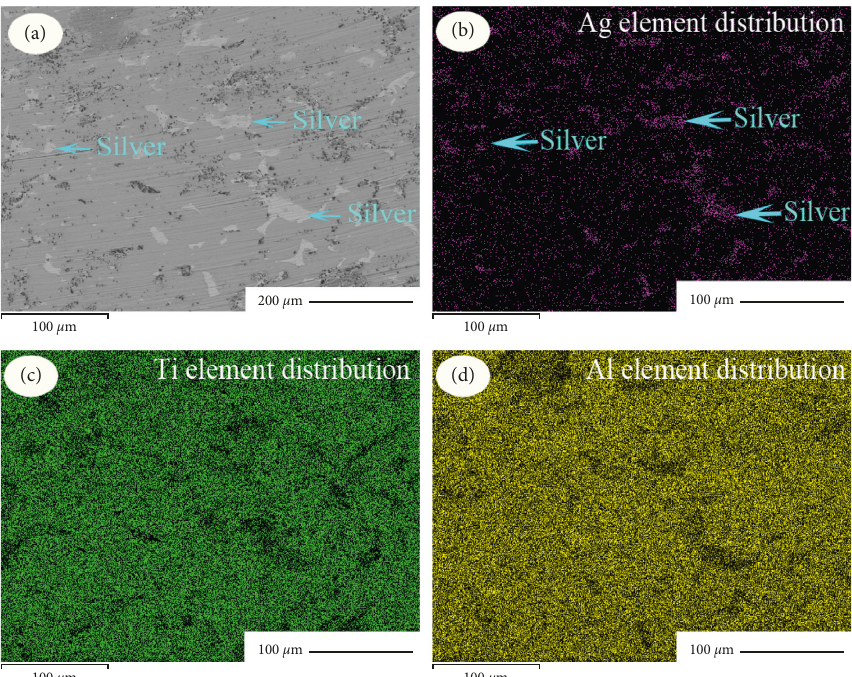
Figure 1: Typical EPMA back-scattering morphology (a) and main element distributions (b–d) of the